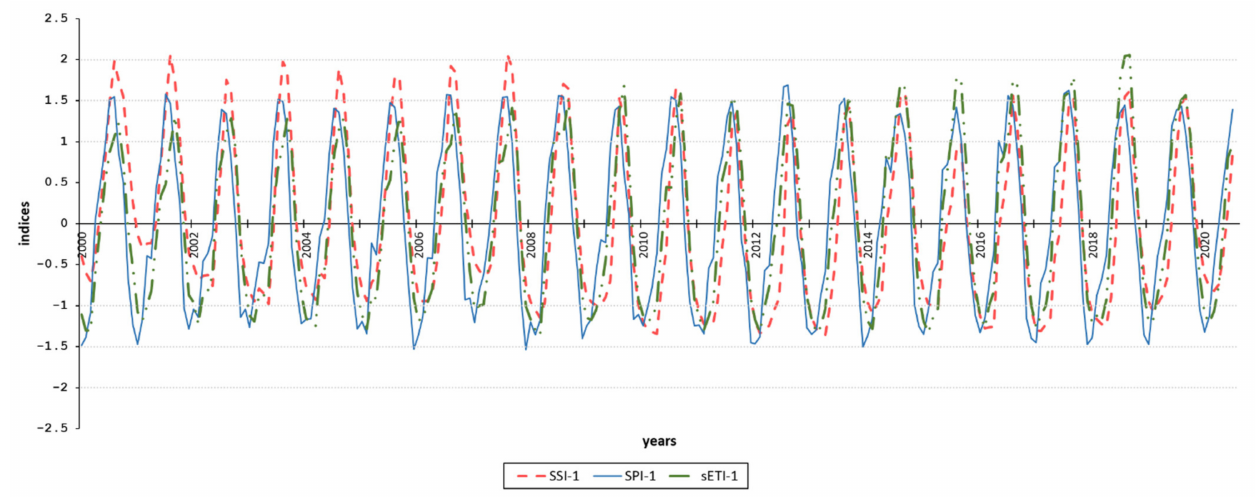
Figure 9. Monthly time steps SPI-1, SSI-1, and